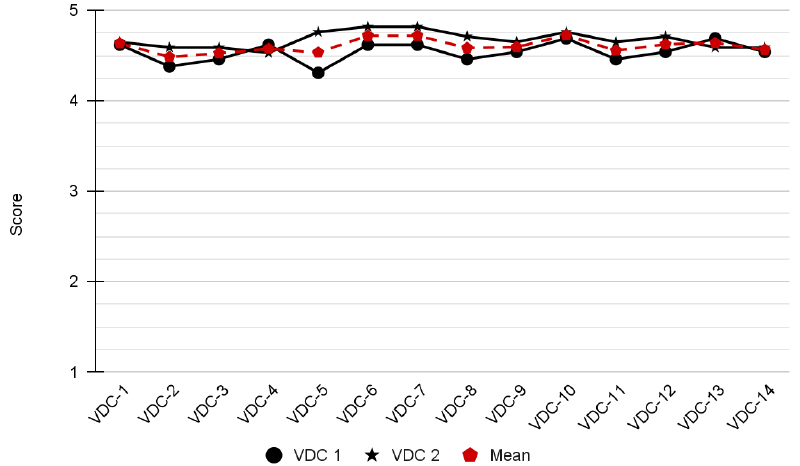
Fig. 5. Survey results on students’ perceptions of VDC methodology in VDC I and VDC II courses